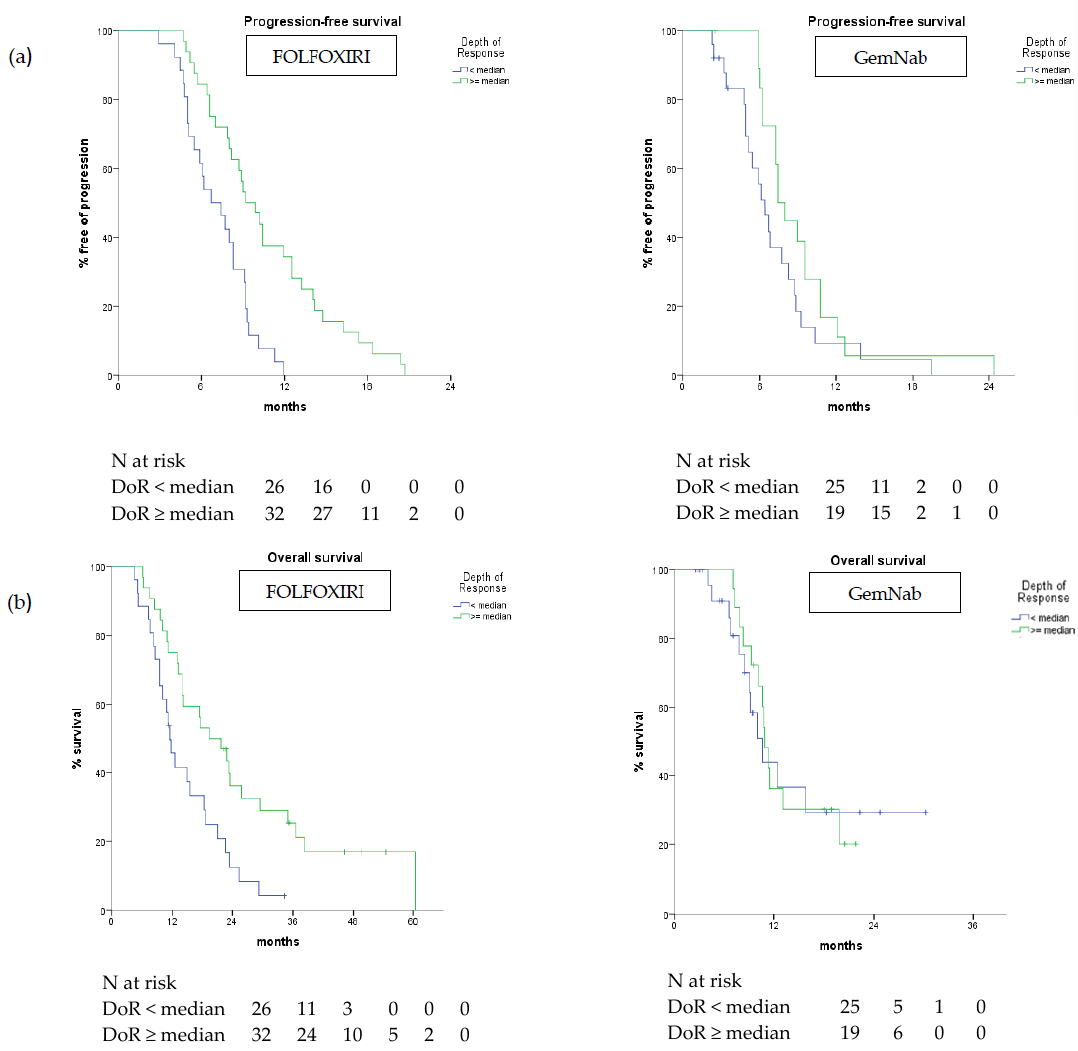
Figure 3. Progression-free Survival ( a ) and Overall Survival ( b ) curves according to DoR quartiles in overall population.